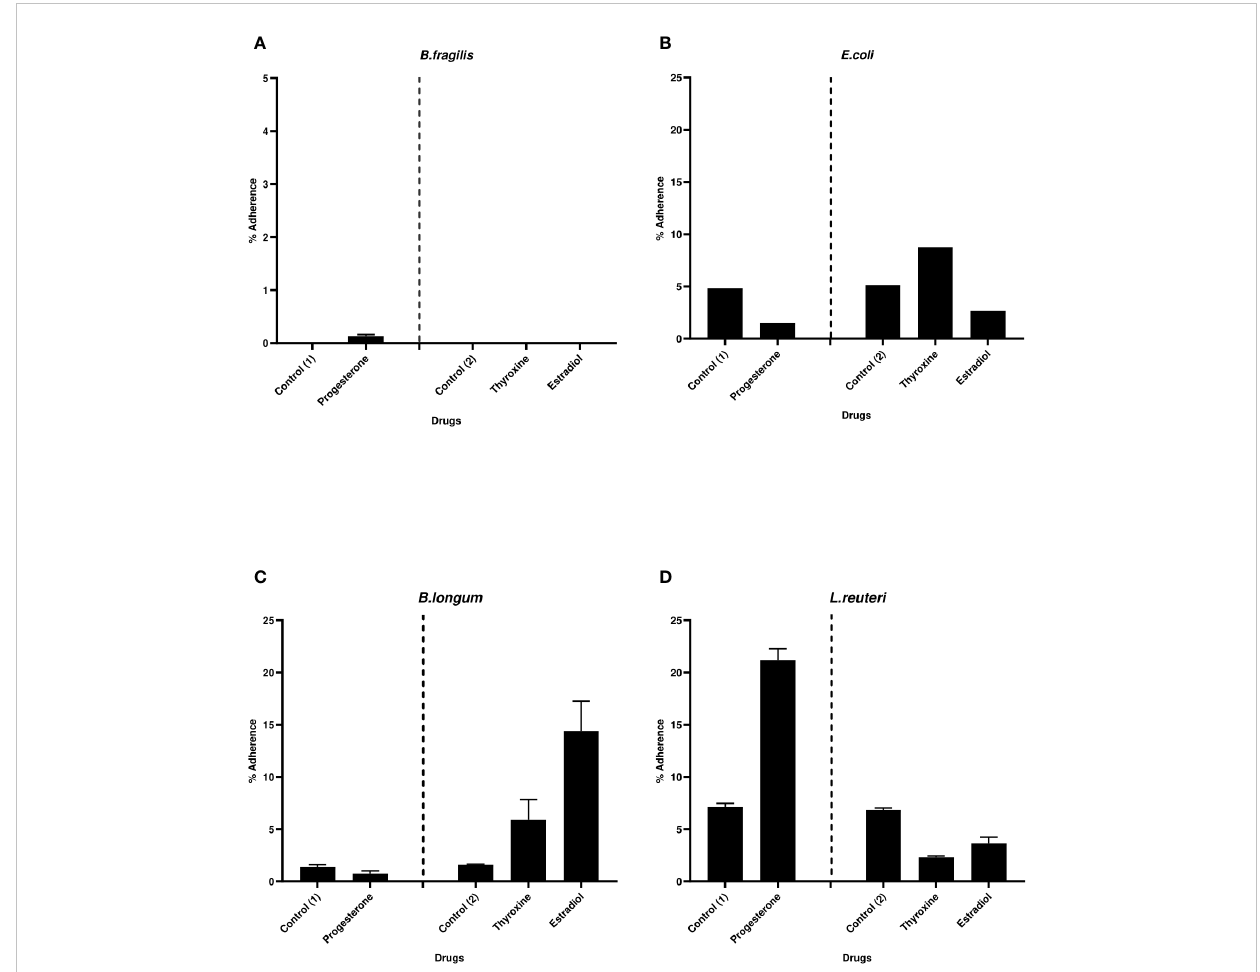
FIGURE 5 Bacterial adherence to Caco-2/HT-29 co-culture under the effect of hormonal drugs. Change in the percentage of adhered bacterial cells (A) B . fragilis ; (B) E. coli ; (C) B . longum ; (D) L. reuteri under the effect of hormonal drugs: progesterone, ethinyl estradiol, and thyroxine in their intestinal concentrations 211.99, 0.562, and 0.0481µM, respectively. Values were expressed as the mean of the percentage of three experiments with error bars (SE). Positive control with bacteria and DMSO at different concentrations equivalent to that used to dissolve drug ( control (1): DMSO 1% and Control (2):DMSO